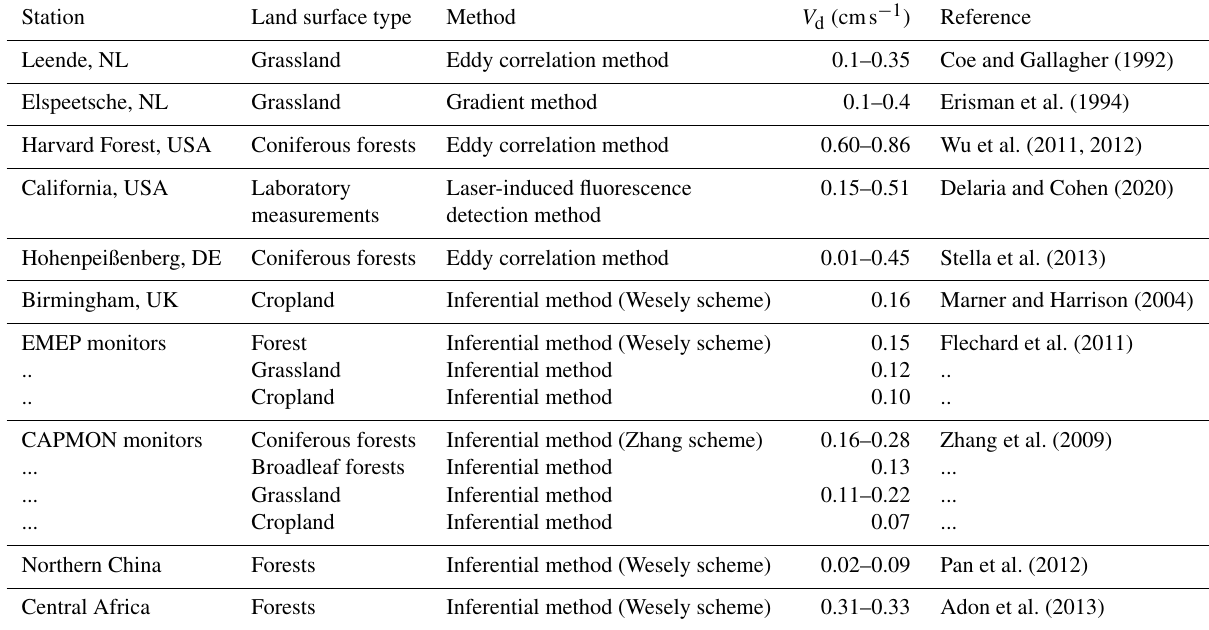
Table 4. Comparison of NO 2 dry deposition velocities with some other